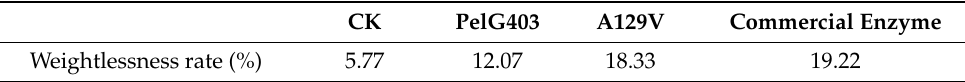
Table 2. Weightlessness rate of